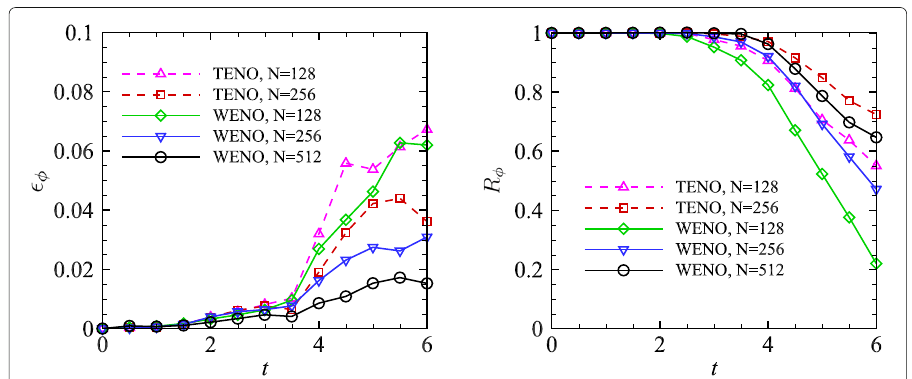
Fig. 14 Temporal evolution of (cid:12) φ and R φ in cases TG1 ∼ TG5 with different numerical schemes and grid resolutions